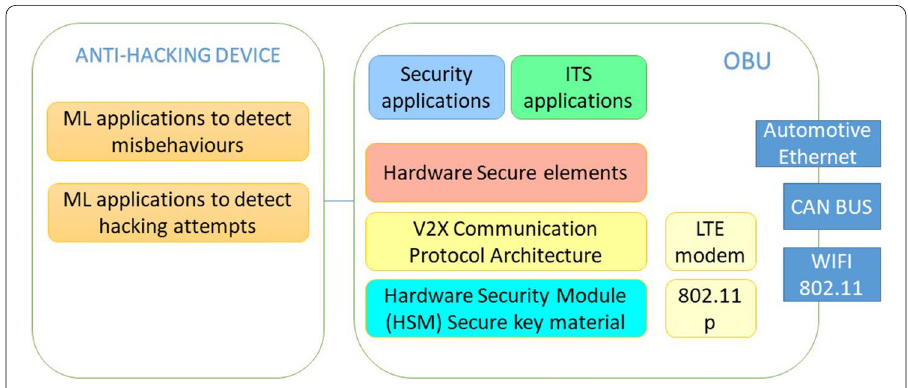
Fig. 3 Architecture of OBU and anti‑hacking device in a cooperative